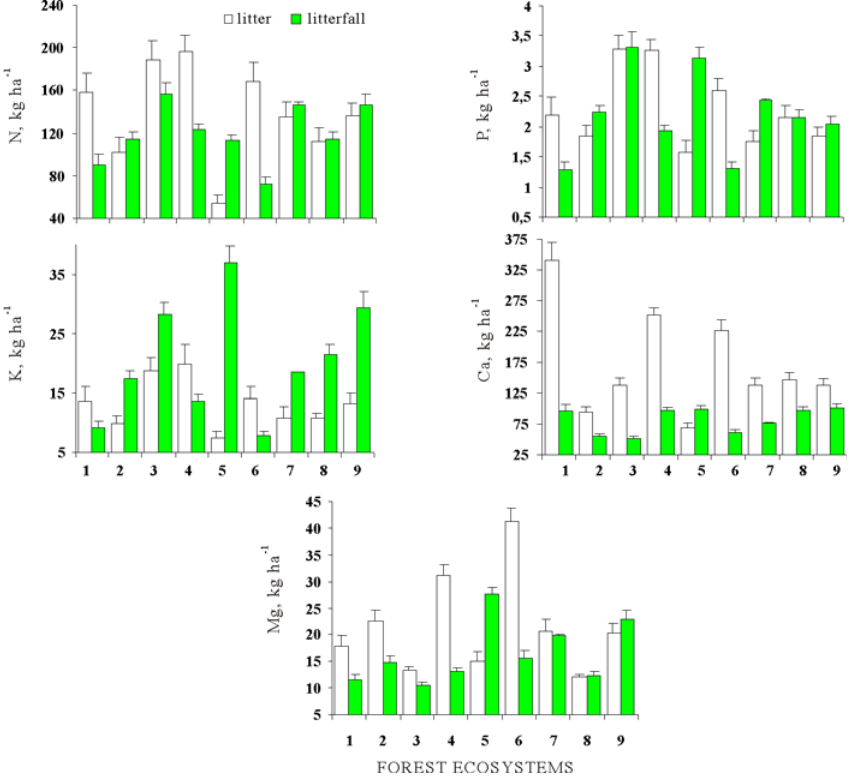
Figure 5. Annual amount (August, 1994 through July, 1995) of N, P, K, Ca and Mg in litterfall and accumulated in the litter layer of different forest ecosystems, in the coastal tablelands of southeastern Bahia. 1: P. angustiflora , 2: C. robustum , 3: A. psilophylla , 4: S. chrysophyllum , 5: C. trichotoma , 6: M. latifolium , 7: mixed-stand, 8: secondary forest and 9: primary forest. Vertical bars indicate standard Table 7. Litter turnover rates ( k - values) and mean residence time of nutrients (MRT) in different forest cover types